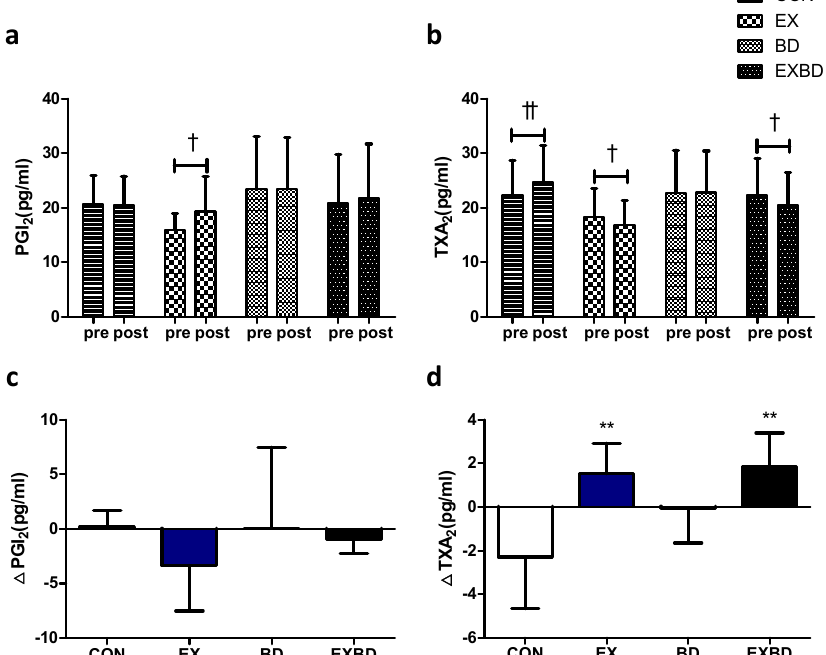
Figure 4. Effect of 16 weeks of aqua exercise and burdock intake on vascular regulation factors in older women with metabolic syndrome. Compared with the baseline values, ( a ) PGI 2 levels were increased in the EX group, and ( b ) TXA 2 levels were decreased in the CON, EX, and EXBD groups after the 16-week intervention. One-way analysis of variance was used to compare the variation in the levels of vascular regulation factors ( c , d ). Data are presented as the mean ± standard deviation. † p < 0.01, †† p < 0.01; before vs. after intervention. ** p < 0.01 vs. CON. PGI 2 , prostacyclin, i.e., prostaglandin I2; TXA 2, thromboxane A2; CON, placebo control, EX, exercise + placebo, BD, burdock, EXBD, exercise + burdock.